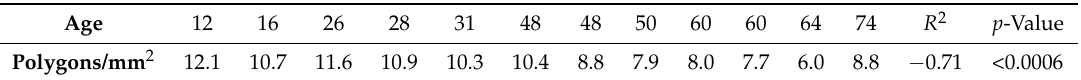
Table 1. Experimental results for skin polygons per surface area in middle volar forearm across 12 volunteers in different age groups using capacitive images. The correlation of the average number of polygons per mm 2 against subjects age is calculated to − 0.71. Reproduced with permission from [33], John Wiley and Sons,